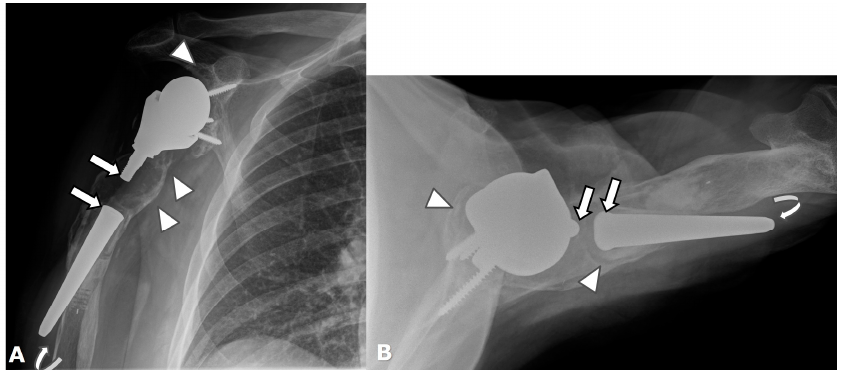
Figure 16. ( A ) Frontal and ( B ) axillary radiographs in a patient with RTSA showing failure of the humeral component, now separated into two separate pieces (white arrows). There is significant lucency (arrowheads) along the humeral and glenoid components, with cortical thinning, suggesting loosening or infection. The distal tip of the humeral component (curved arrow) breached the cortex and became extraosseous in location.